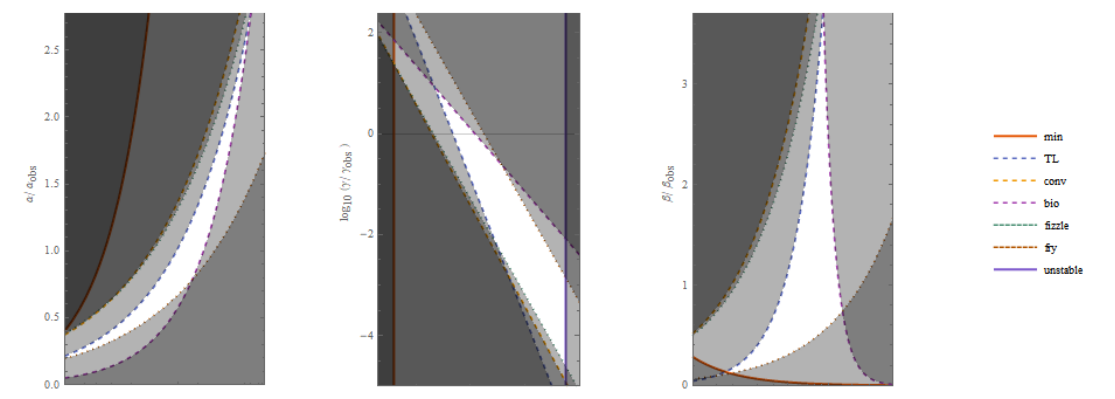
Figure 8. Habitable range of stellar masses for various choices of requirements. The shaded regions are treated as inhospitable for the various habitability